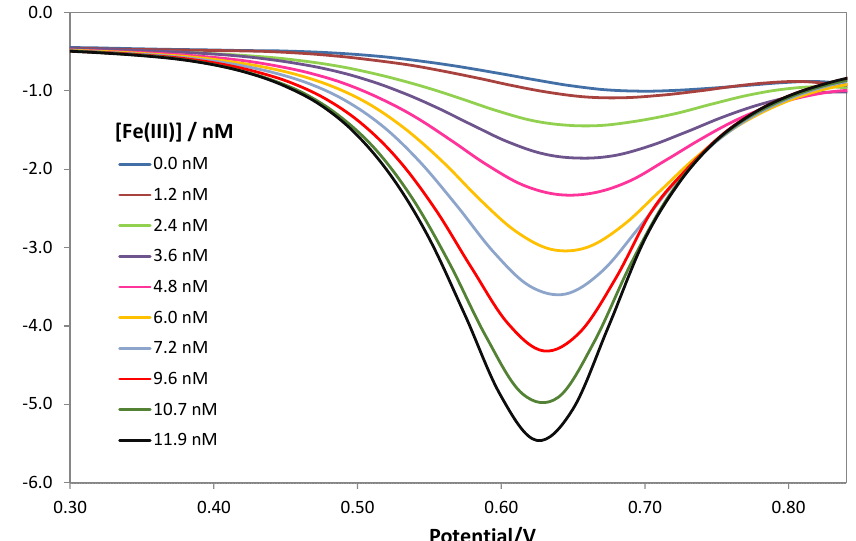
Figure 3. Schematic representation of Fe(III) determination procedure by Scheme 1. min), the quantity of iron(III) reaching the electrode surface is small, and only after immersion in solutions at high Fe(III) content, a signal significantly different to that of the background appeared. Otherwise, if selecting a longer accumulation time (higher than 5 min), a saturation of the DFO sites of the monolayer occurred. After different trials, the time selected was two minutes, which is a good compromise to obtain significant current peaks also for Fe(III) solutions at nM levels and pretty good linearity of the dose/response curve.